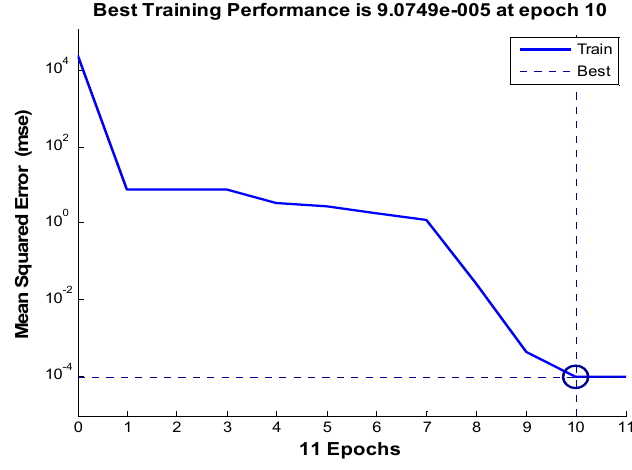
Figure 7. Training plot.